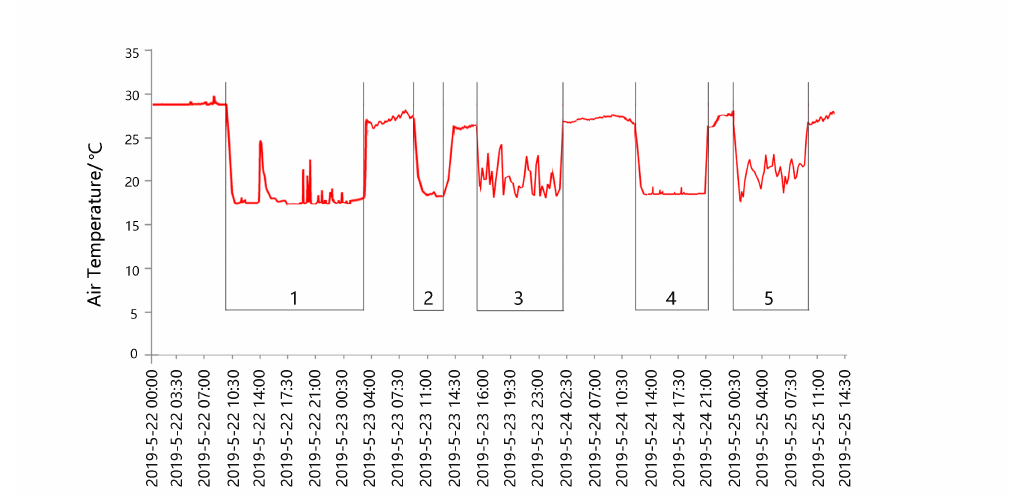
Figure 11. Indoor air-conditioner temperature change from 22 to 25 May